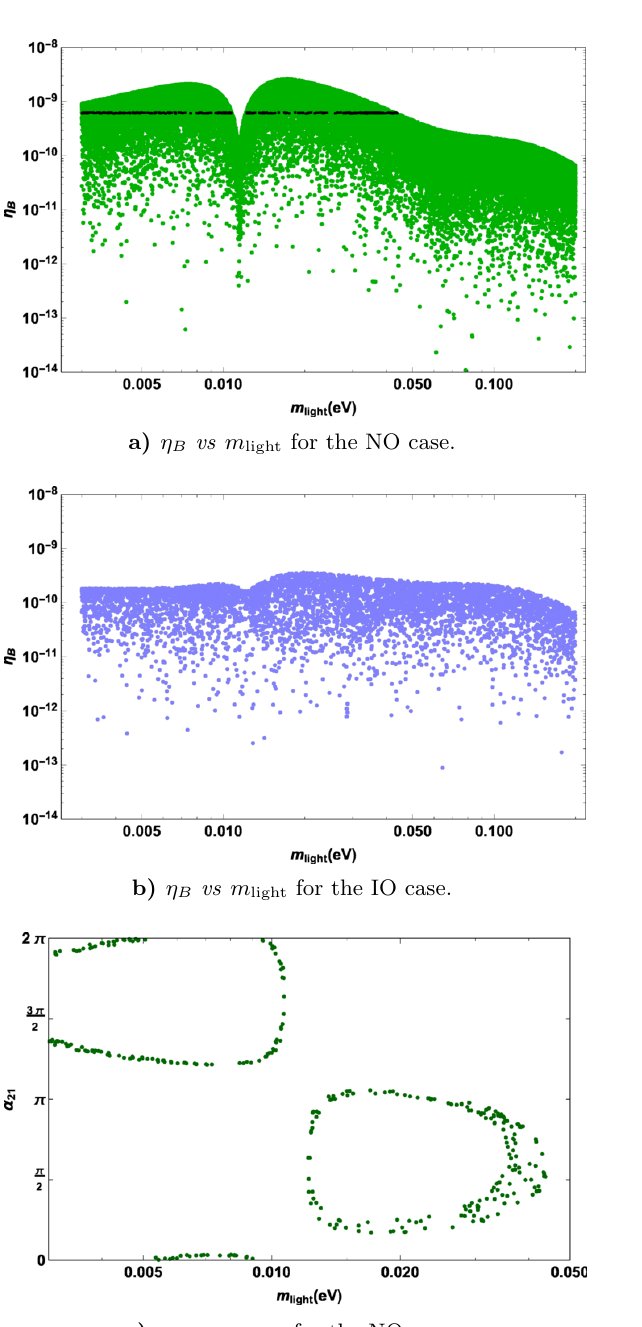
Figure 8 . (cid:17) B as a function of the lightest neutrino mass for the NO on the top and IO in the middle. In black the points where (cid:17) B falls inside its experimental determination at 3 (cid:27) error. The correlation between (cid:11) 21 and m light in the bottom for the NO case only: the points corresponds to the black ones in the (cid:12)rst plot with (cid:17) B inside its experimental value. Charged lepton masses and neutrino oscillation parameters have been taken at their central value as in table 1, 0 : 01 . z < 20, c 1 = c 2 = 0 : 01 and the Majorana CP phases randomly vary in their dominium.